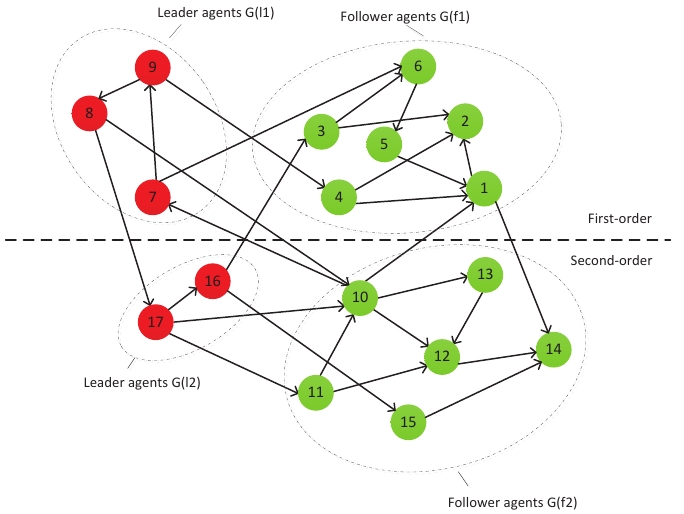
Figure 1. Legend for a discrete-time MAS with heterogeneous and two-time-scale features in the leader–follower